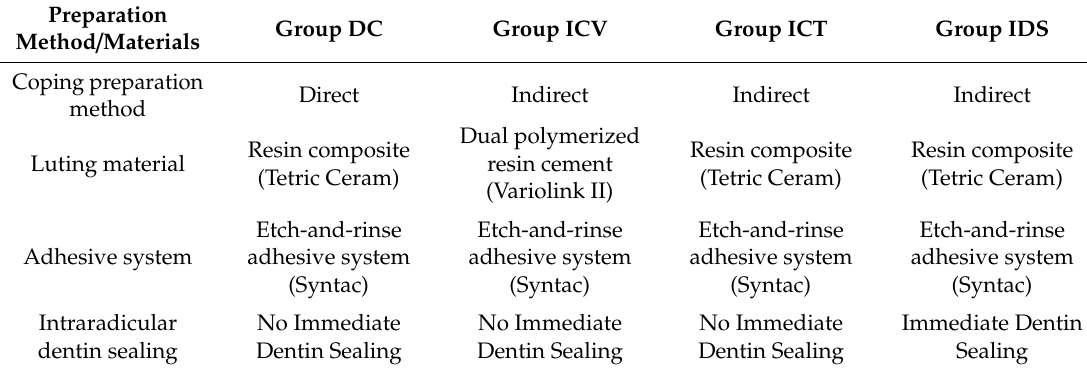
Figure 1. ( a – i ) Sequential phases of specimen preparation and testing. ( a ) Extracted tooth isolated with rubber dam to increase the working conditions of the operator, ( b ) removal of coronal part of the tooth with diamond bur at cement-enamel junction (CEJ), preparation of occlusal / incisal surface of tooth using diamond bur with light concavity in order to increase adhesive surface, ( c ) preparation of elliptical inlay to achieve stability and avoid rotational movement during cementing procedure, ( d ) checking vertical position of retentive male part (GP-Ball), ( e ) obtaining stone cast from silicon impression of the preparation and molding coping at the laboratory, ( f ) try-in of the coping, ( g ) cementation of the coping on the tooth, ( h ) positioning the specimen in the Universal Testing Device, ( i ) tensile test until failure of the coping. Table 1. Description of experimental groups with regard to preparation method, luting cement, bonding agent and intraradicular dentin sealing method.